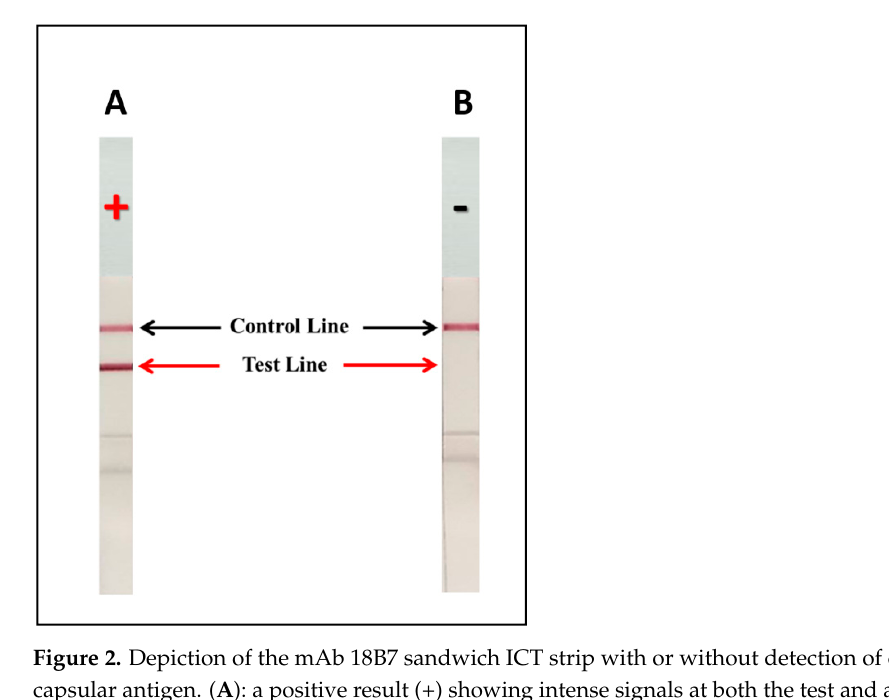
Figure 1. A schematic of mAb 18B7 sandwich ICT strip for the rapid detection of cryptococcal cap- sular antigen from clinical samples . ( A ) , the schematic presentation of the positions where colloidal gold conjugated mAb 18B7, mAb 18B7 and goat anti - mouse IgG antibodies are immobilized in an analytical nitrocellulose membrane . ( B ) , the reactions that occur on the mAb 18B7 sandwich ICT strip in the presence of cryptococcal capsular antigen and ( C ) , in the absence of cryptococcal capsu- lar antigens . The red – purple color of colloidal gold conjugate appears at the test line and / or control line, depending on the presence o r absence of cryptococcal capsular antigen in the clinical sample .